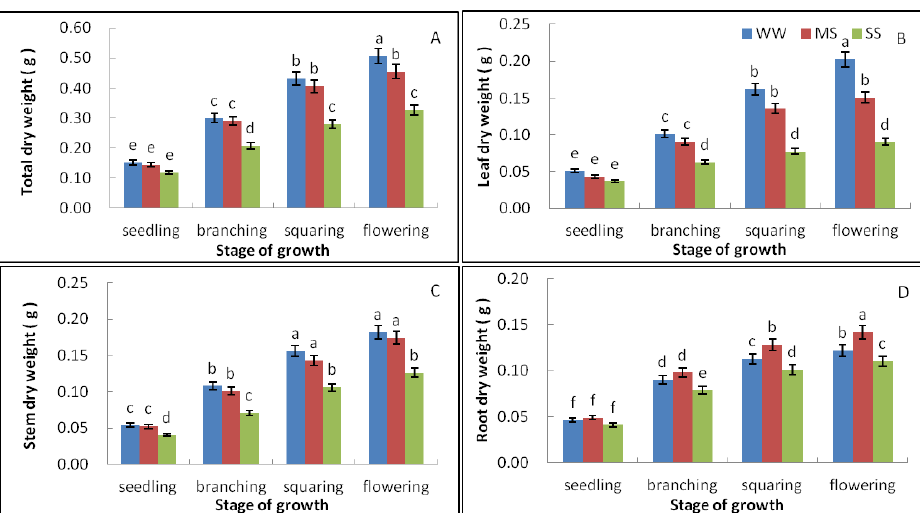
Figure 3. Effect of watering treatment (WW: water-sufficient (85% PC), MS: moderate water stress (65% PC), and SS: severe water stress (45% PC)) on ( A ) total dry weight per plant, ( B ) leaf dry weight per plant, ( C ) stem dry weight per plant, and ( D ) root dry weight per plant at four growth stages: seedling, branching, squaring, and flowering. The bars are ± one standard error of the mean ( n = 4). Different lowercase letters represent significant differences at p < 0.05 according to Tukey ’s multiple range test ．